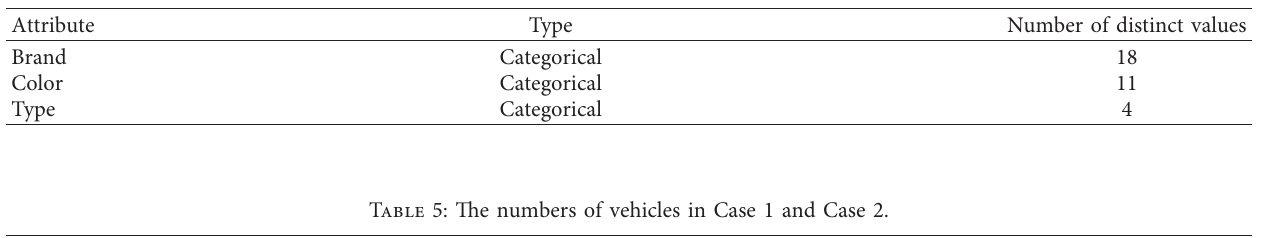
Table 4: Description of attributes.